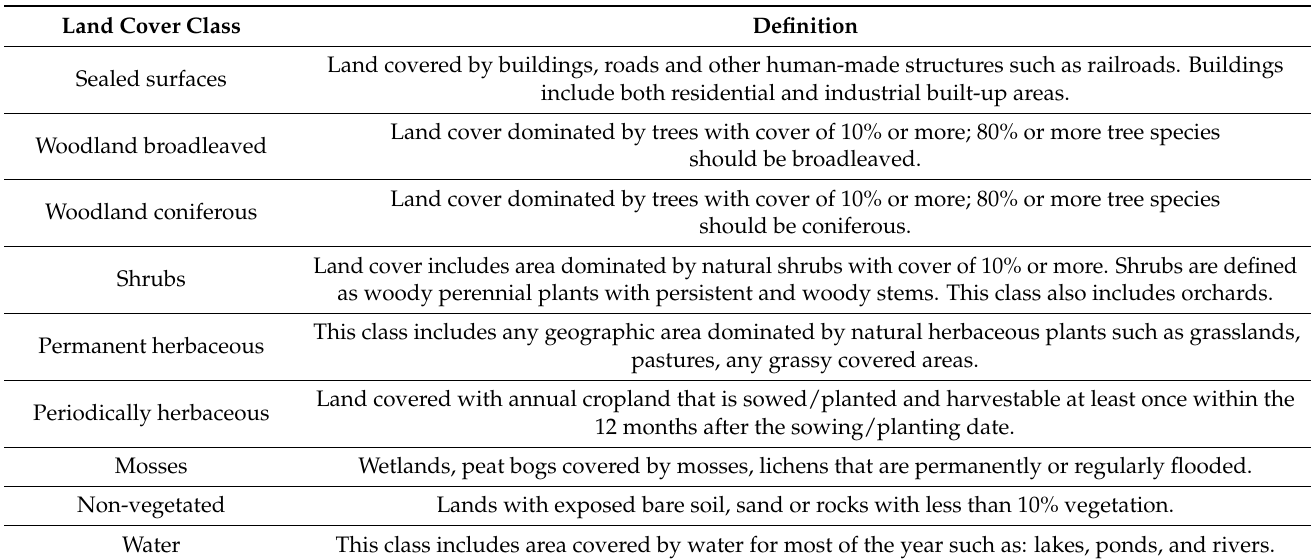
Table 2. Land cover class nomenclature; definitions correspond to the Copernicus Global Land Cover. Land Cover